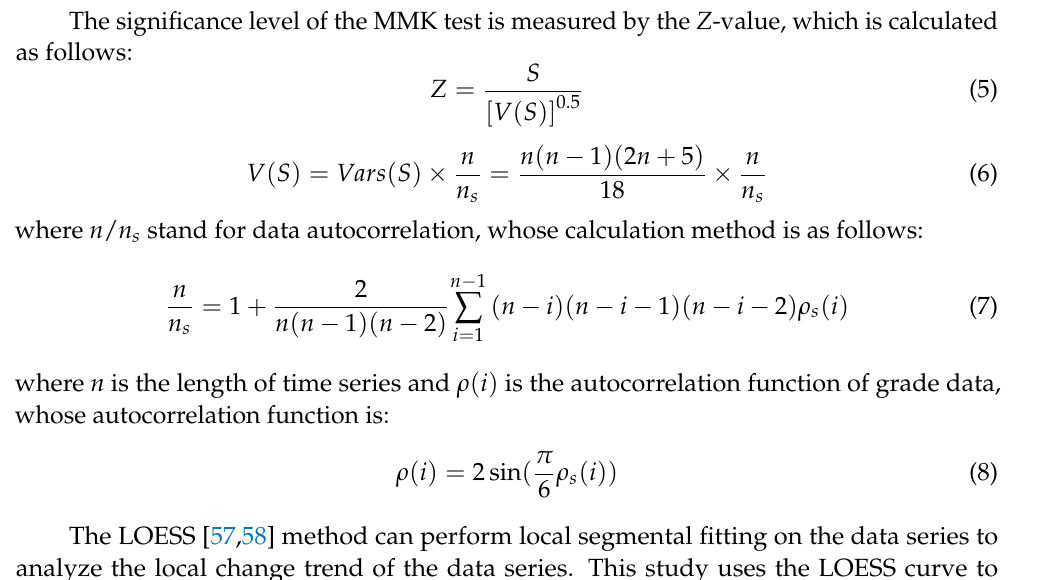
Figure 4. Multi-year precipitation maps of the sites and MSWEP. Figure 5 shows the spatial distribution of RB, CC, and RMSE of MSWEP and ground site data from January 1981 to December 1999. On the whole, the correlation between MSWEP data and ground site data is strong. The average CC of all sites reaches 0.81, the average RMSE is 28.22, and the stations with CC values above 0.8 account for 72% of the total sites. In the four basins, MSWEP in Basin I (average CC = 0.71, RB = 14.76, RMSE = 32.86) and Basin II (average CC = 0.89, RB = 15.18, RMSE = 27.45) outperformed those in Basin III and Basin IV. It is worth noting that the performance of MSWEP in some sites is poor, such as the outer and the southeastern of Basin I, and some sites in the upper Basin III all show obvious overestimation. This may be related to the fact that topographic rain produced by local complex terrain cannot be effectively captured by remote sensing data.